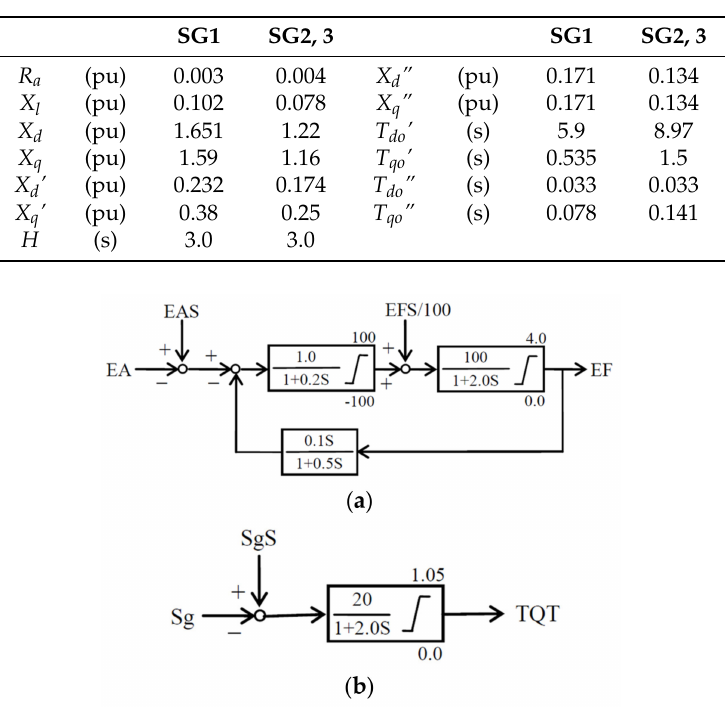
Figure 5. Generatorcontrolmodel: ( a )automaticvoltageregulator(AVR);( b )governor. EA:terminalvoltage, EAS: terminal voltage reference; EF: field voltage; EFS: field voltage reference; Sg: generator